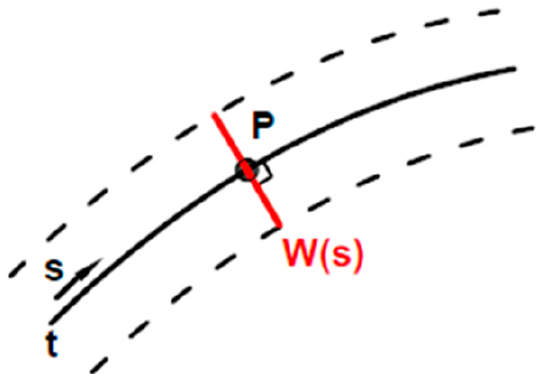
Figure 1. Representation of a general spatial trajectory t and related constraints W(s) . Authors’ elaboration according to [25].